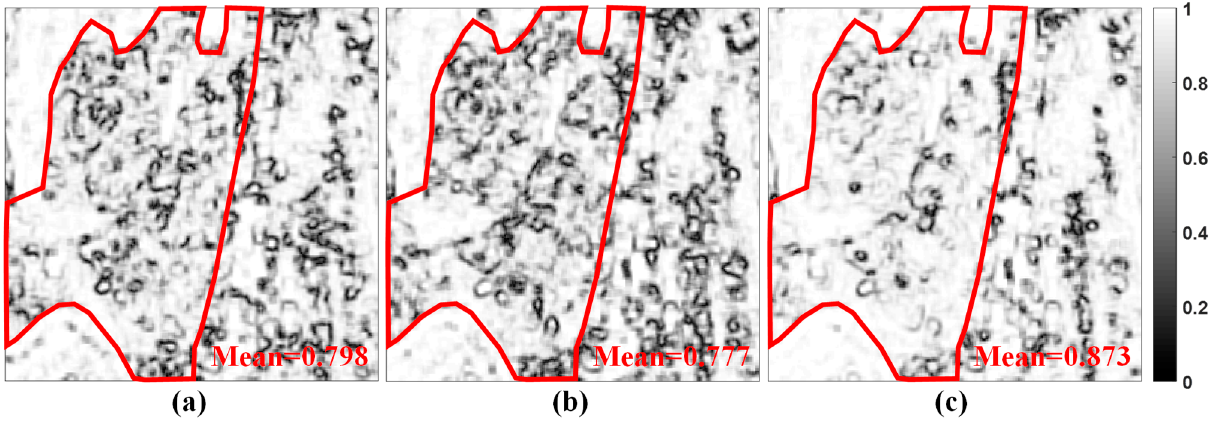
Figure 11. Estimated SPC images of ROI (250 × 250 pixels) using ( a ) HH, ( b ) ESPO, and ( c ) proposed TSTP methods. The estimated SPC means over the natural scene are shown in Figure 11. The lowly coherent natural area is marked by the red irregular boxes in Figure 11a–c.